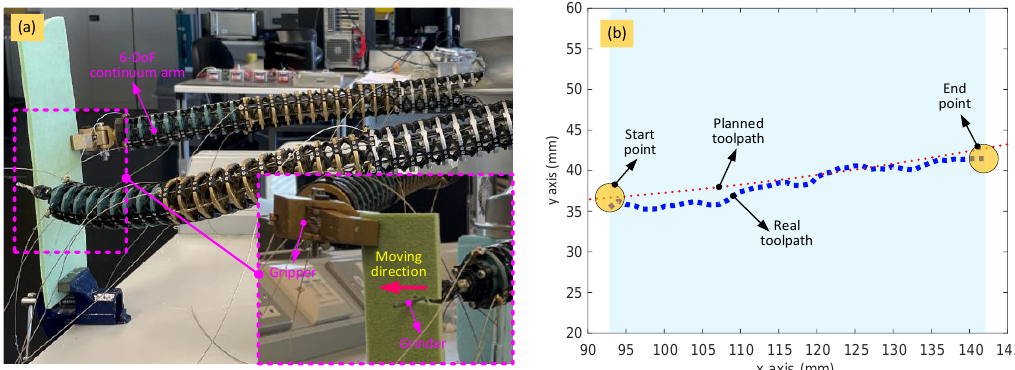
Figure 16. Experimental setup of the collaborative dual-arm robotic system and experimental results: ( a ) snapshot of the system with one arm holding the structure while the other arm conducts the cutting operation for the material removal; ( b ) experimental result between the desired toolpath and the actual toolpath.